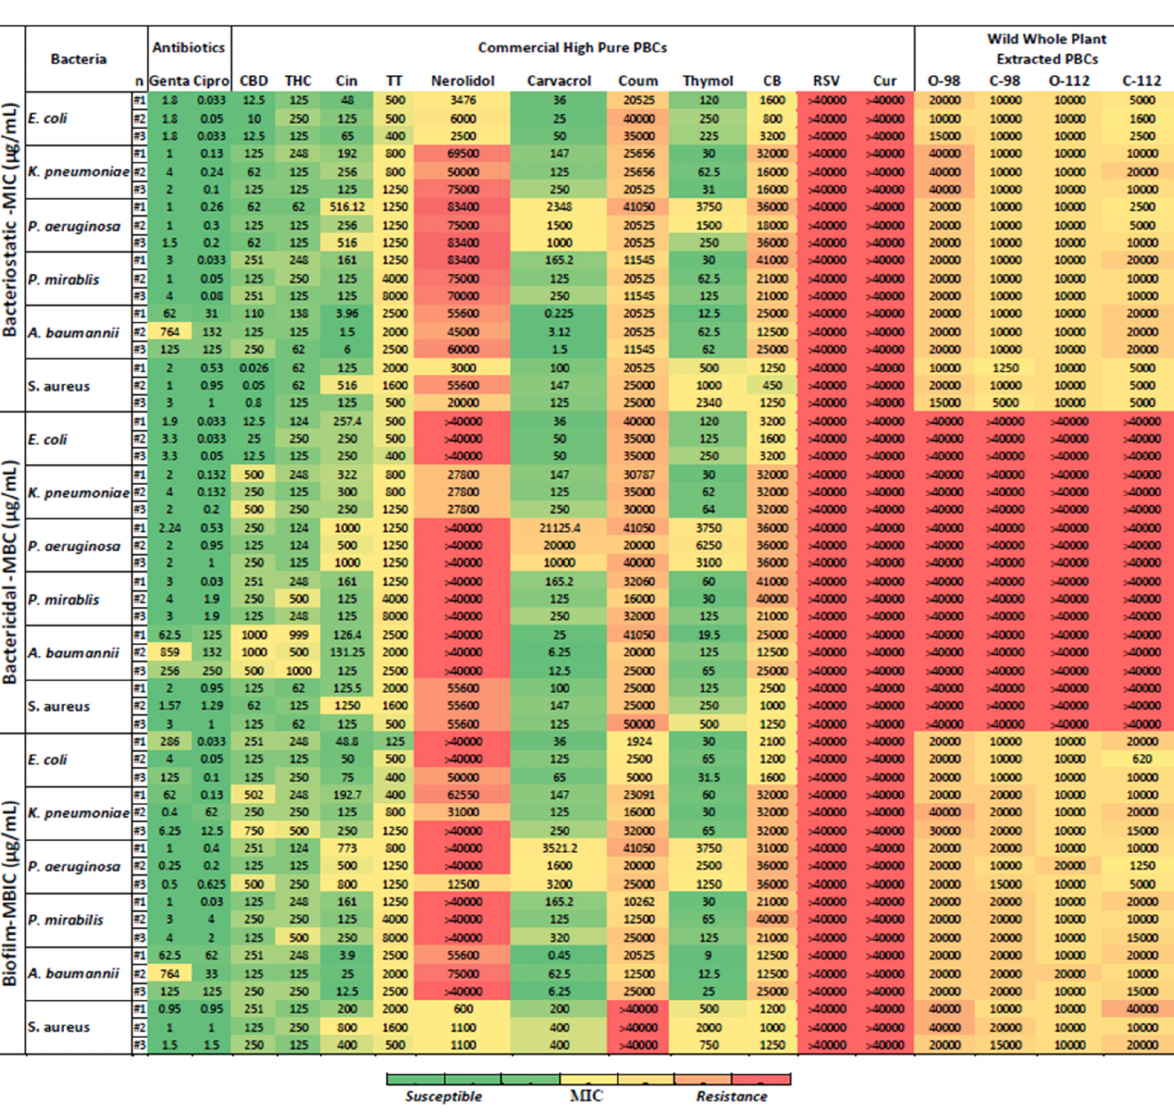
Figure 1. Minimum inhibitory concentration (MIC), minimum bactericidal concentration (MBC), and minimum biofilm inhibitory concentration (MBIC) of 15 different plant-based natural compounds (PBCs) against various pathogens of concern. Genta = gentamicin; Cipro = ciprofloxacin; Cin = cin- namaldehyde; TT = tea tree oil; Coum = coumaric acid; CB = Canada balsam; RSV = resveratrol; Cur = curcumin; n = number of